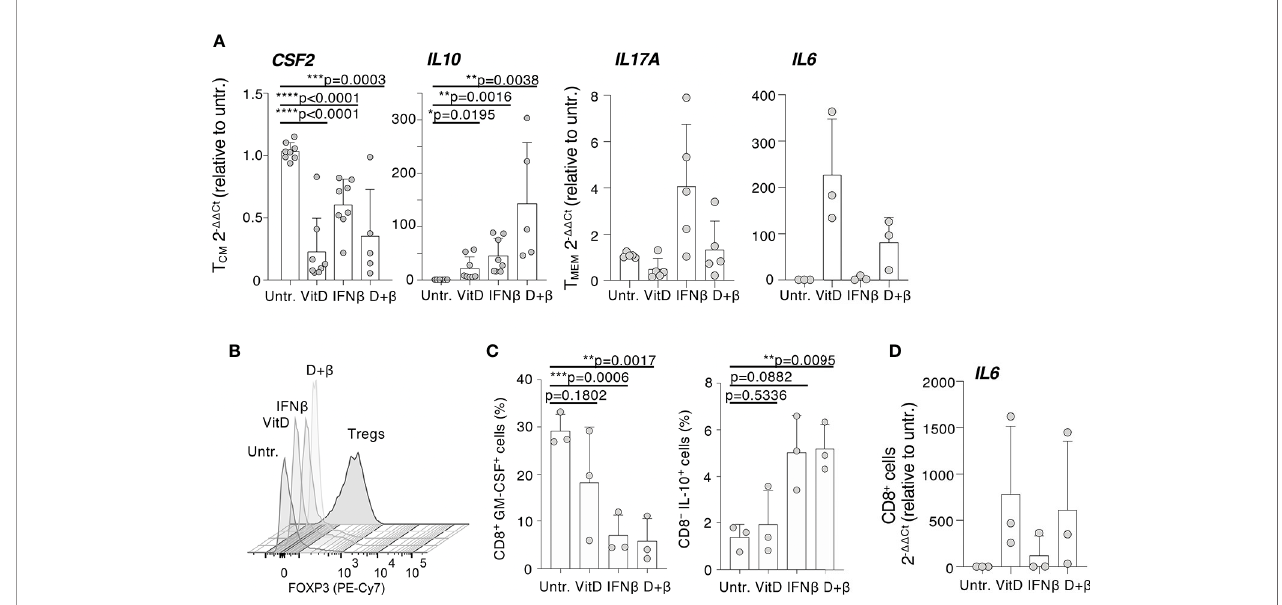
FIGURE 4 | Modulation of speci fi c immune transcripts in CD4 + and CD8 + T lymphocytes. (A) CD4 + T cells (either T CM or total memory, T MEM ) were activated with plate-bound anti-CD3 and anti-CD28 antibodies in the presence or absence of vitamin D and/or IFN- b . Expression of the indicated transcripts ( CSF2 , IL10 , IL17A , and IL6 ) was determined by qRT-PCR. Each dot represents one donor (at least n=3). Mean ± SD; unpaired t-test, two-tailed, relative to untreated cells. (B) Memory CD4 + T lymphocytes were stimulated and treated with vitamin D and/or IFN- b . At day 5, expression of FOXP3 was determined by intracellular staining. Freshly isolated Treg cells were also used in comparison (representative of n=2 independent experiments). (C) Memory CD8 + T lymphocytes were stimulated and treated with vitamin D and/or IFN- b . After 5 days, the percentage of cells expressing the indicated cytokines was determined by intracellular staining. Each dot represents one donor (n=3). Mean ± SD; paired t-test, two-tailed, relative to untreated cells. (D) CD8 + T lymphocytes treated as in (C) were used to extract RNA and measure IL6 expression by qRT-PCR. Each dot represents one donor (n=3). Mean ± SD. * p < 0.05; **p < 0.01; ***p < 0.001; ****p <